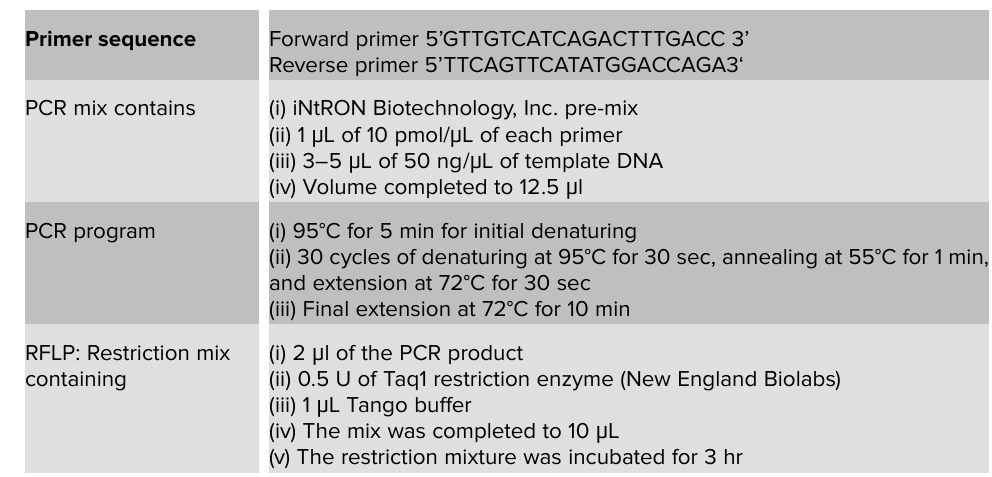
TABLE 1: The RFLP–PCR method